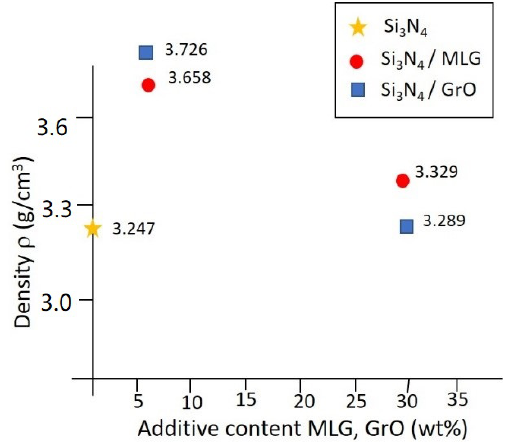
Ceramics 2020 , 3 FOR PEER REVIEW Figure 5. Measured density of Si 3 N 4 -based composites. Figure 5. Measured density of Si 3 N 4 -based composites.